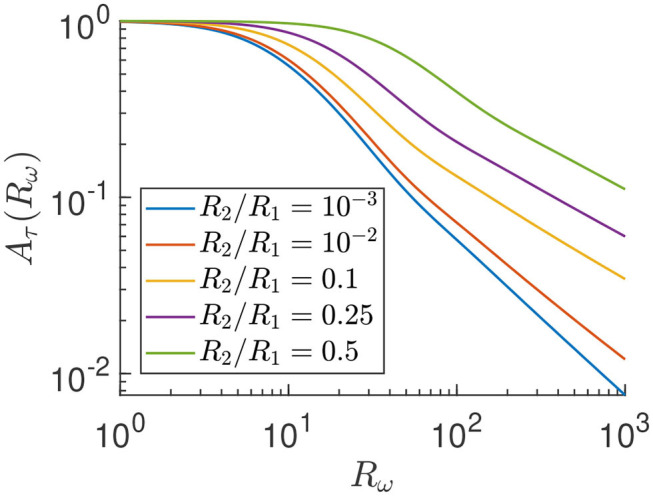
Reduction factor Aτ of the time-dependent shear stress amplitude compared to the stationary stress as in Equation (5) on log-log scale.